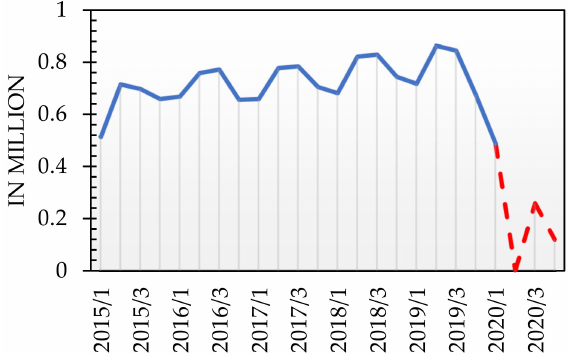
Figure 5. Number of passengers at the Warsaw Modlin Airport.